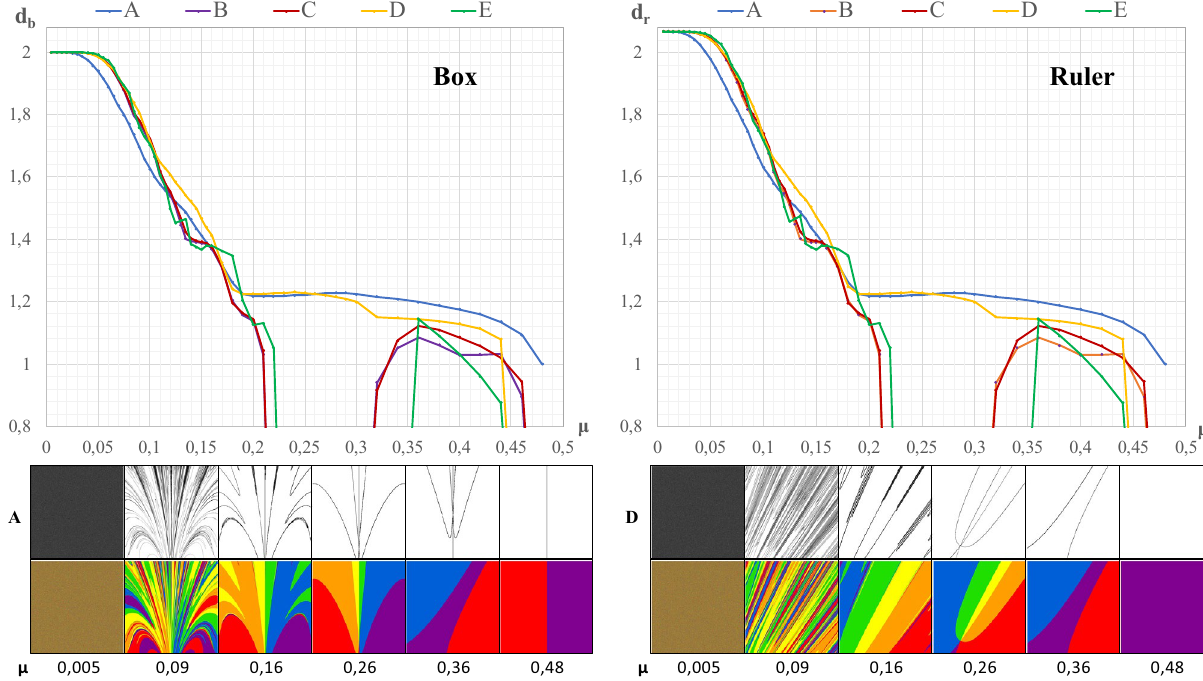
Figure 6. Distribution of the values of fractal dimensions of the boundaries of the attraction basins identified in selected fragments of a fractal; Legend: ( A , D )-fragments marked in Fig.